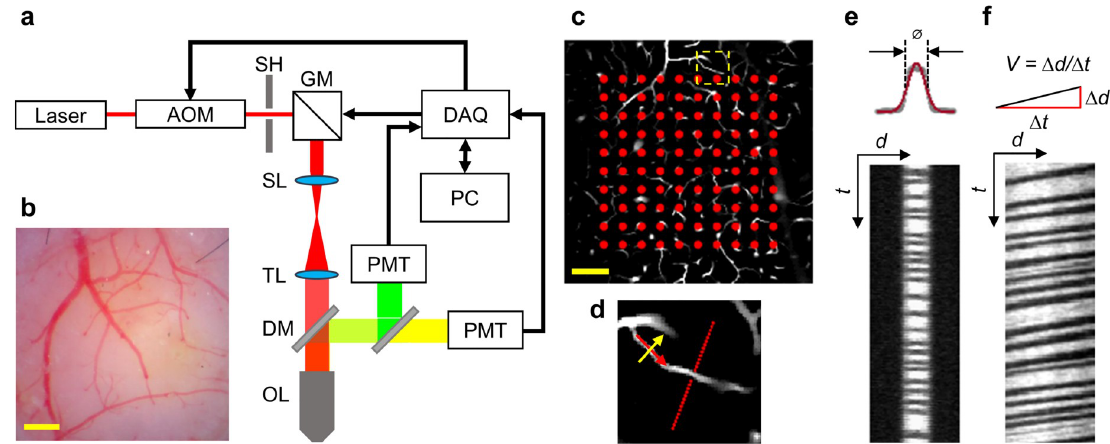
Fig 1. Experimental setup and acquisition protocol. a. Schematic diagram of the two-photon microscopy system. The components are abbreviated as: acousto-optic modulator (AOM), shutter (SH), Galvo mirror (GM), scan lens (SL), tube lens (TL), dichroic mirror (DM), objective lens (OL), photomultiplier tube (PMT), data acquisition card (DAQ), and personal computer (PC). b. A representative CCD image capturing the mouse brain surface vasculature. Scale bar: 500 μ m. c. Illustration of the 2D grid of locations (red dots) marked for PO 2 acquisition performed in the cortical tissue within the capillary bed. The red dashed square encloses a capillary, used as an example of blood flow and tissue PO 2 gradient acquisition in d . Scale bar: 50 μ m. d. The red dots in the vascular image illustrate the measurement locations for tissue PO 2 gradient, perpendicular to the capillary axis. In the same capillary, perpendicular and longitudinal line-scans were performed, as illustrated by the yellow and red arrows, respectively. The arrows indicate the line-scan directions. e and f. Representative perpendicular ( e ) and longitudinal ( f ) line-scan images utilized to extract capillary RBC flow properties and diameter. In e , ø , d and t represent diameter, distance and time, respectively. In f , the RBC speed V was calculated by the ratio of the distance interval ( Δ d) to the time interval ( Δ